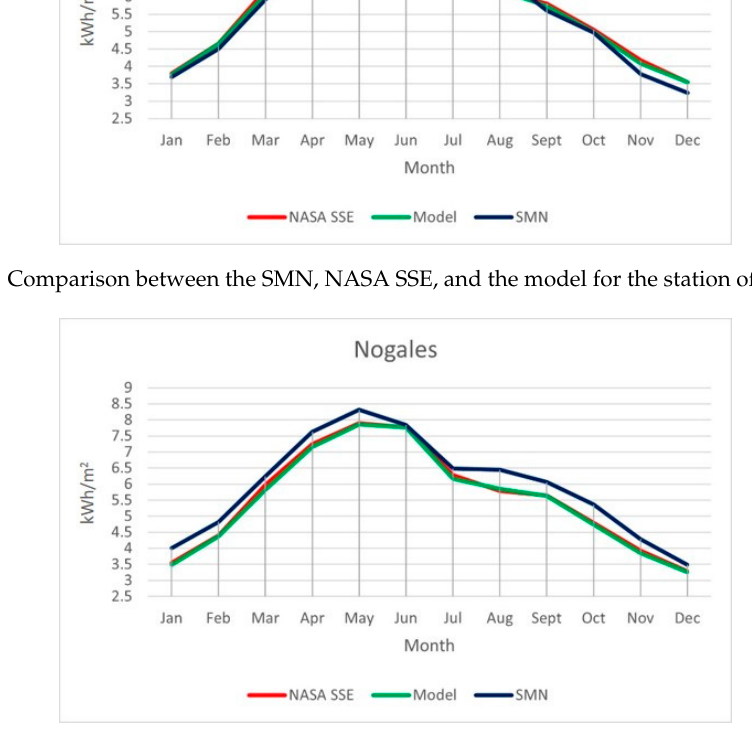
Figure 5. Comparison between the SMN, NASA SSE, and the model for the station of Nogales.